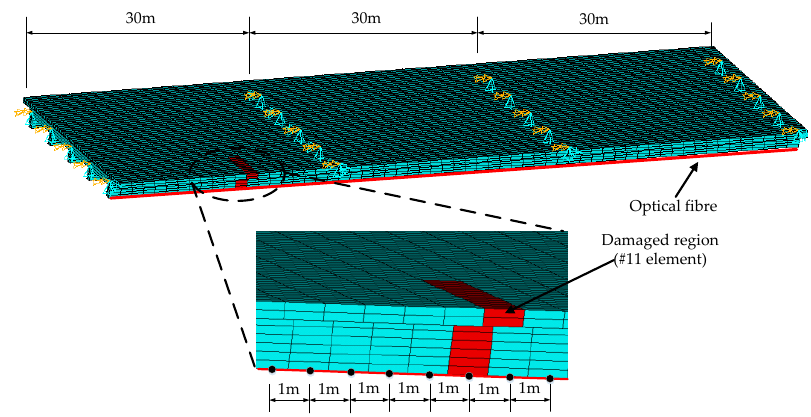
Figure 3. Schematic of the quasi-static loading of a bridge with a long sensing fiber.